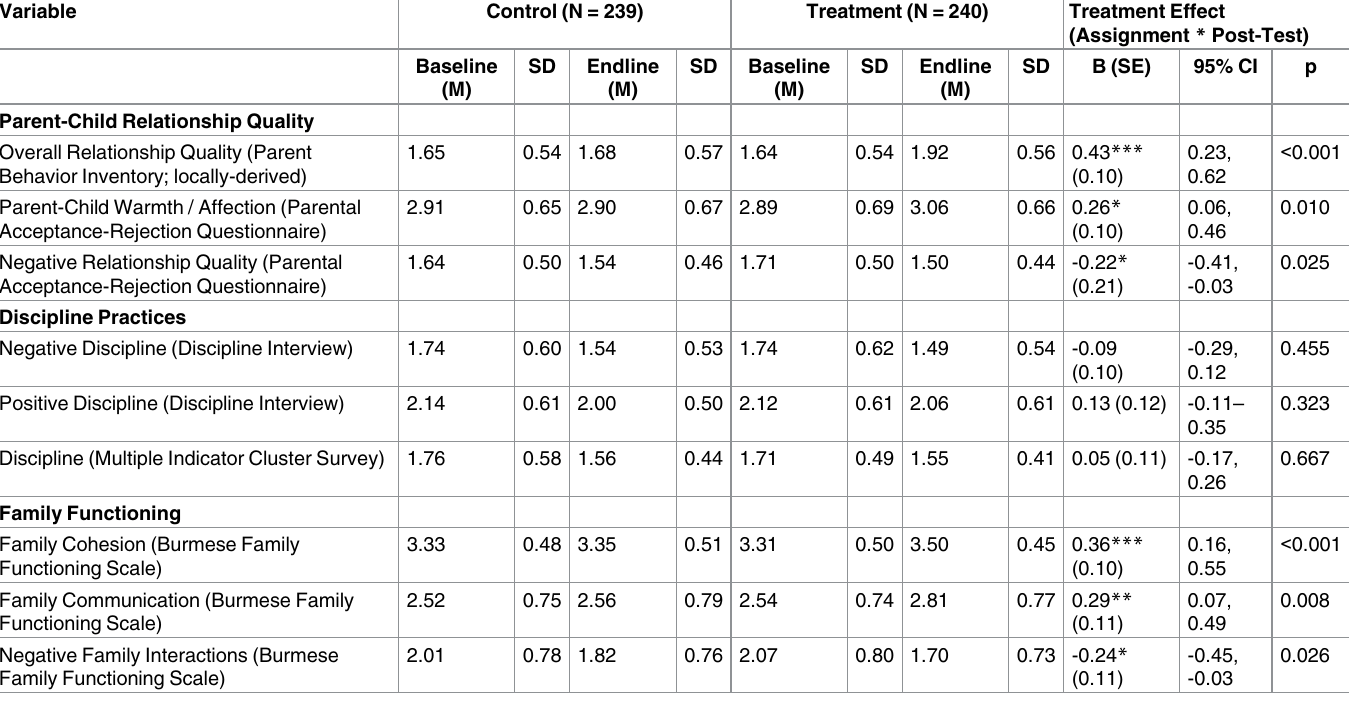
Table 4. Outcomes: Child-Report: Difference-in-differences analysis results (1-month follow-up).